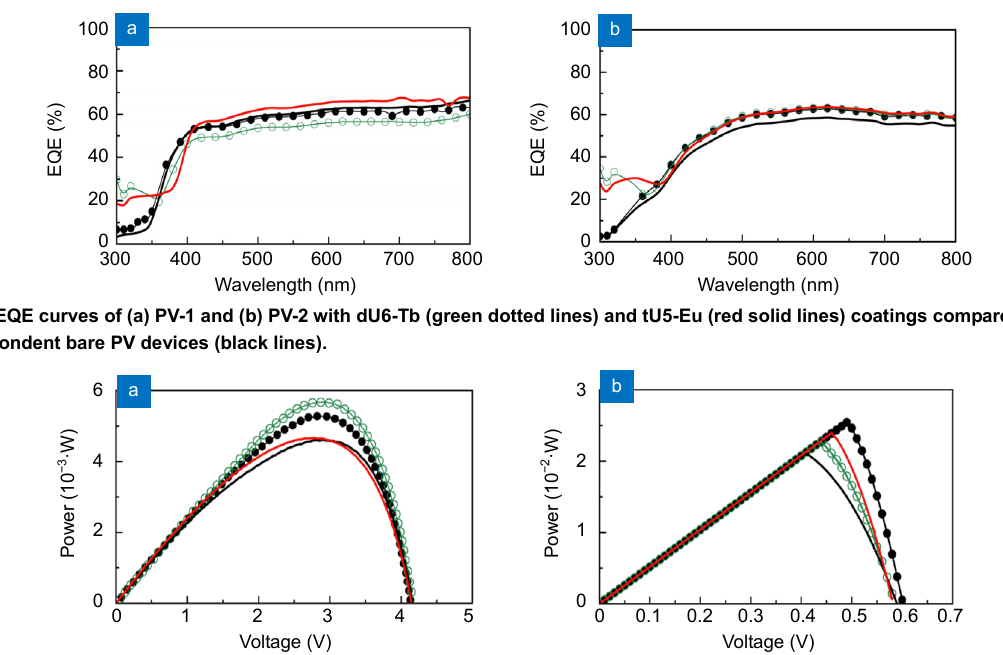
Fig. 5 | V-P curves of (a) PV-1 and (b) PV-2 with dU6-Tb (green dotted lines) and tU5-Eu (red solid lines) coatings compared with the cor- respondent bare PV devices (black